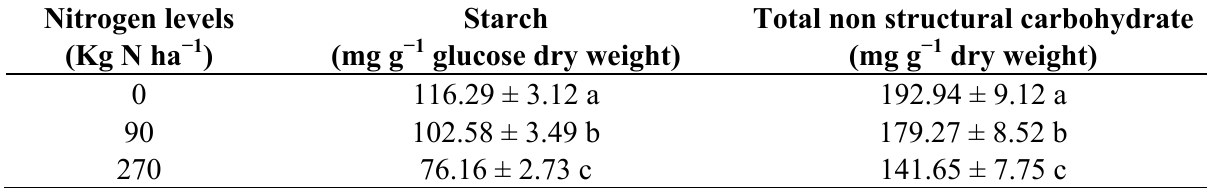
Table 3. The effects of nitrogen levels on starch and total non structural